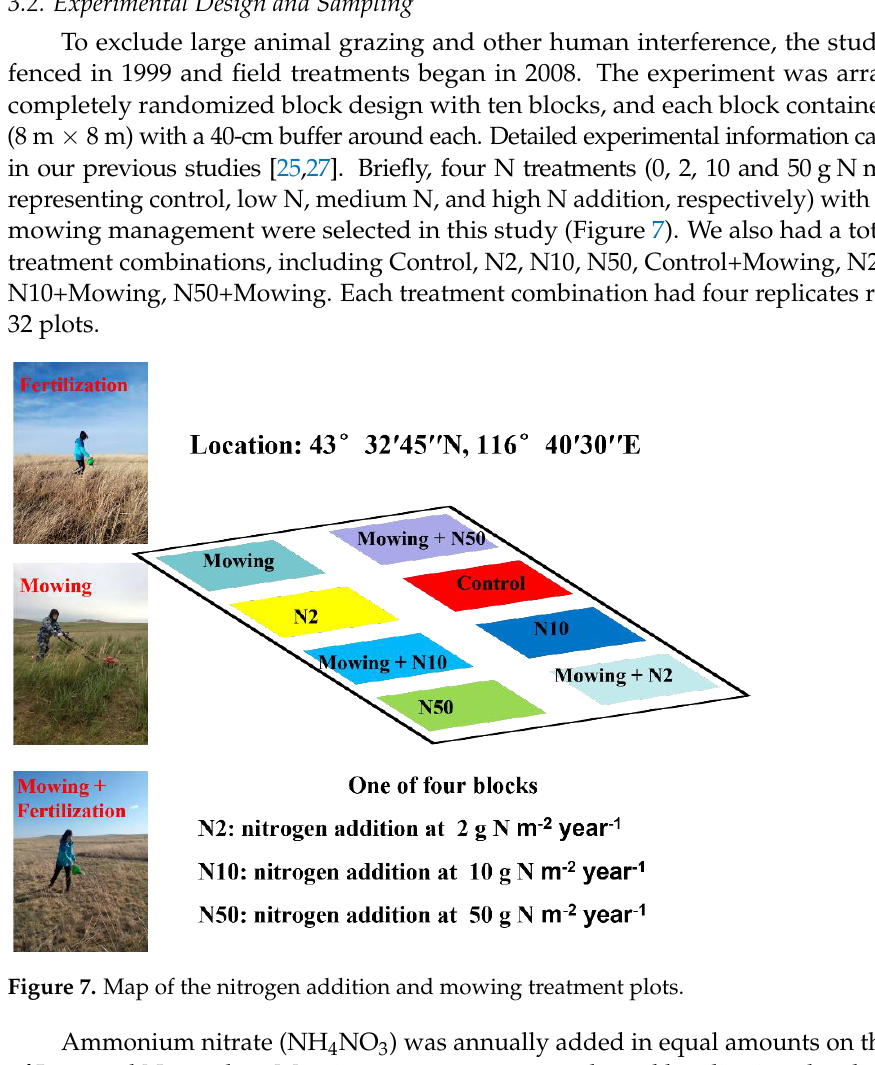
Figure 6. Pearson correlations among six micronutrients (Fe, Mn, Cu, Zn, Co, and Mo) in above- ground plants ( a ), litter ( b ), roots ( c ) and soil ( d ). Red circles indicate positive correlations, whereas bule circles indicate negative correlations, and the symbol × indicates insignificant correlations.